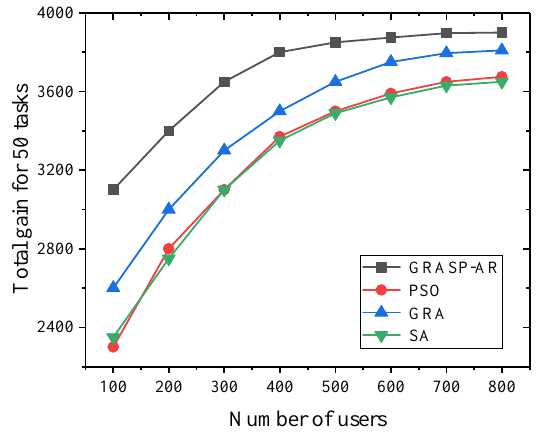
Figure 8. The total gain achieved for 50 tasks vs. the number of users